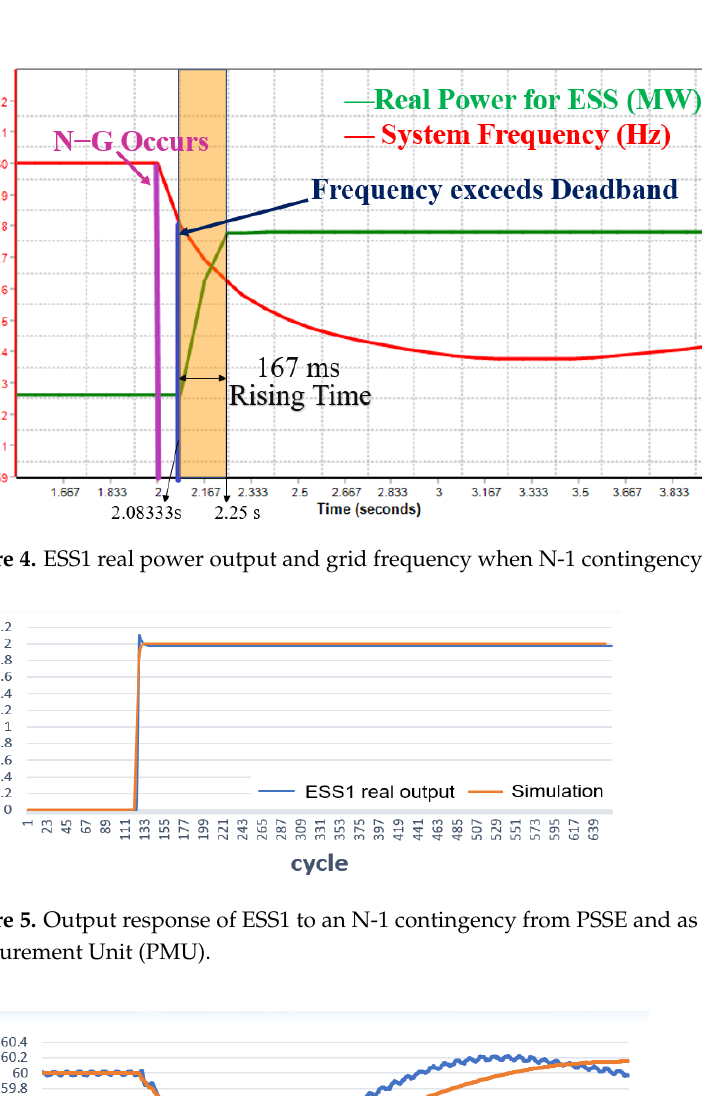
Figure 5. Output response of ESS1 to an N-1 contingency from PSSE and as measured from phasor measurement Unit (PMU).